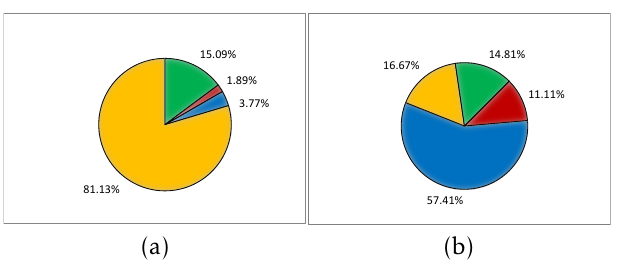
Figure 5. (a) Were all projects you reviewed finished and